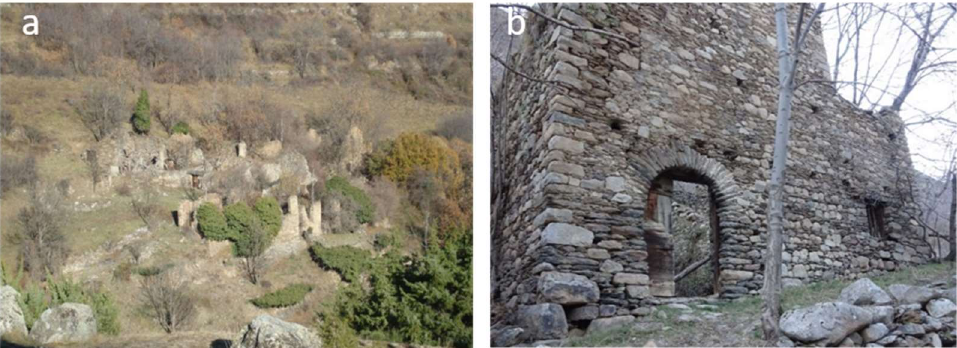
Figure 6. ( a ) Ruins of old Àrreu, known today as Bordes d’Àrreu; ( b ) some architectural features such as this door arch reveal that the old Àrreu ruins had been houses before being used as barns.